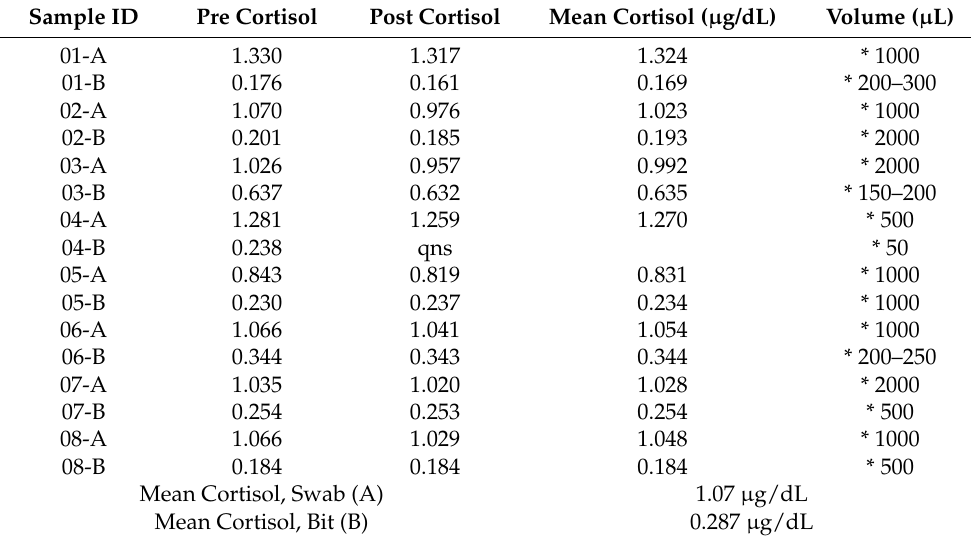
Table 1. Initial Pre-Pilot Sampling of Bit vs. Swab Saliva